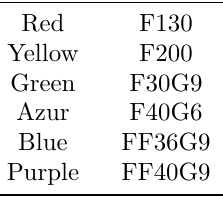
Table 3. Colour description for core layout.